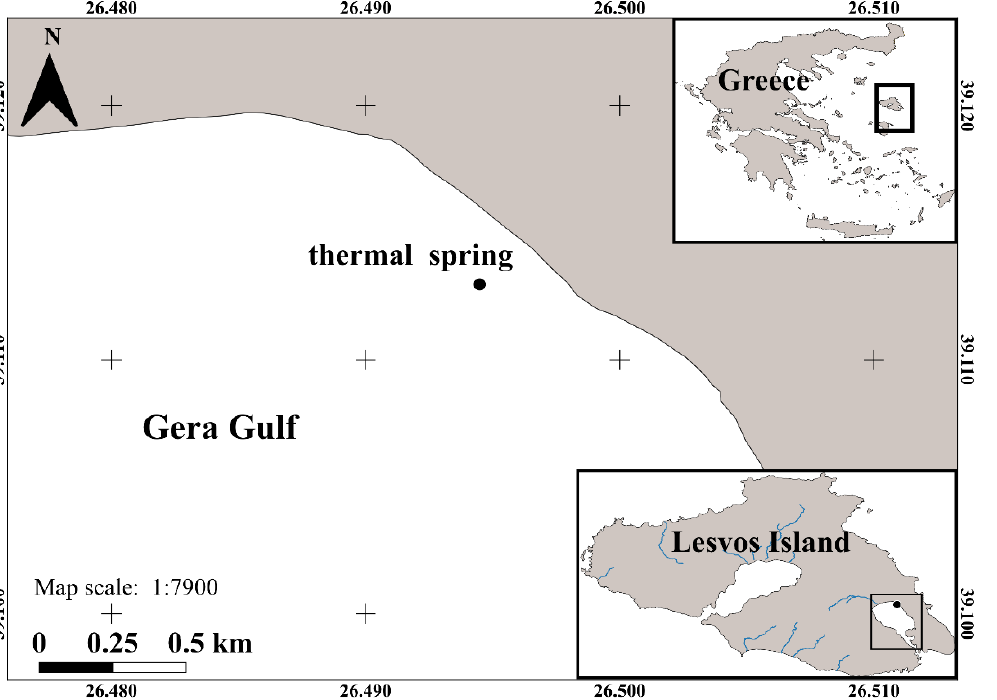
Figure 1. Map of the study area (thermal spring) in Lesvos Island, Greece.